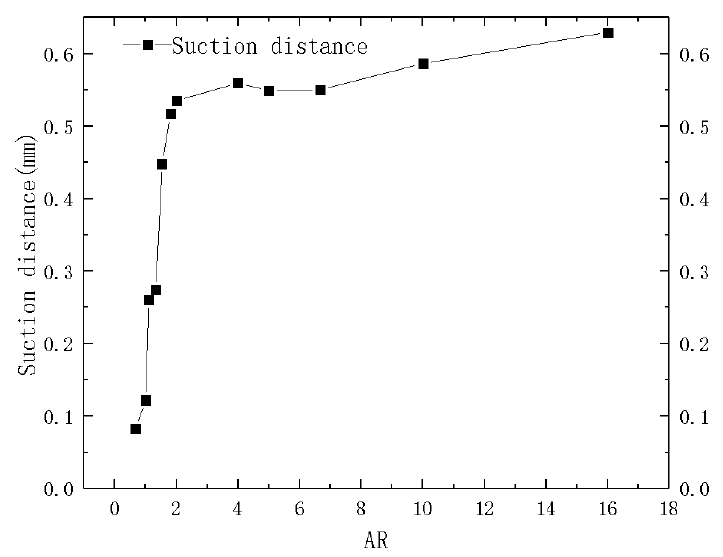
Figure 6. Microchannel suction distance changing with ARs. The relationship between the suction distance and the ARs of the microchannel was obtained through data fitting, and a deviation of less than 15% was observed compared with the numerical simulation. Therefore, Equation (12) could be used to calculate the ARs of the microchannel and the suction distance.